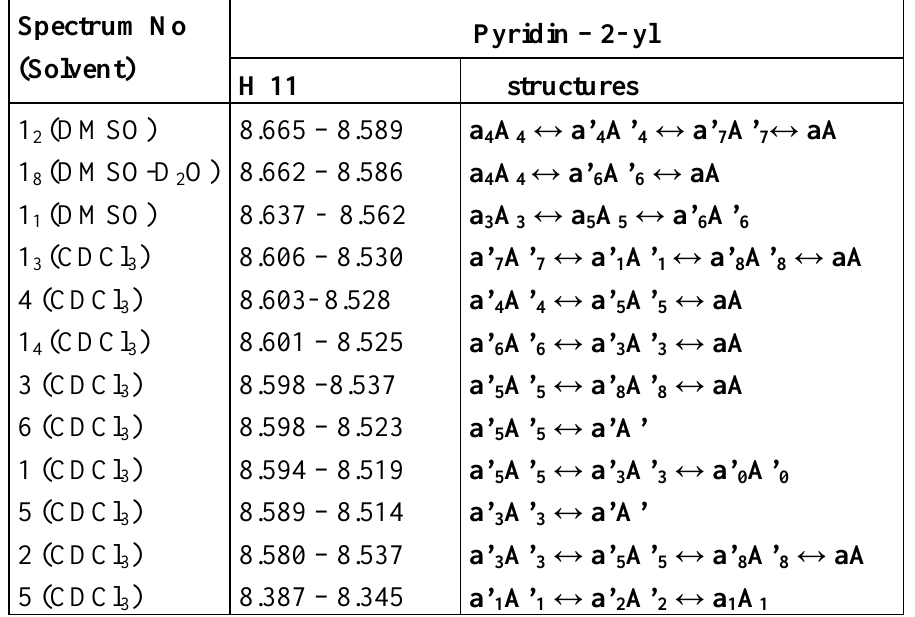
Table 7 . The 1 H-NMR chemical shifts δ [ppm] from TMS of 1